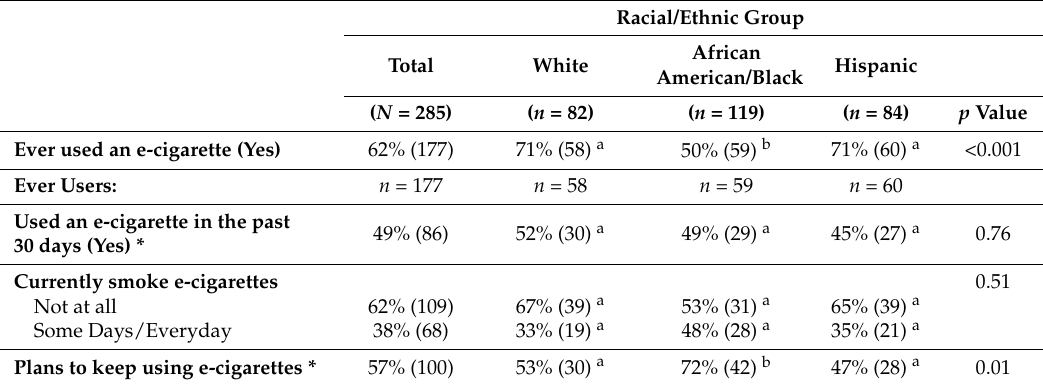
Table 2. Unadjusted Analyses of E-Cigarette Use by Racial/Ethnic